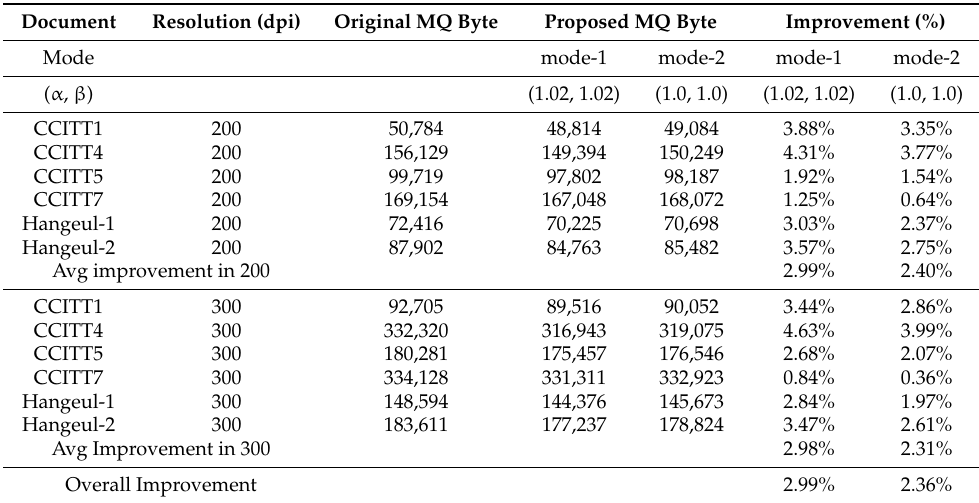
Table 11. Experimental results for each mode using 2-level LUT for binary images.